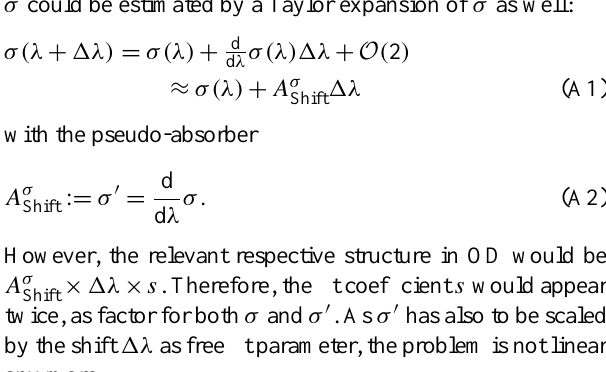
Fig. A1. As Fig. 4, but for shifts in the absorption cross-section of NO 2 . The fitted shifts/stretches for A σ an order of magnitude due to the remaining nonlinearities (see